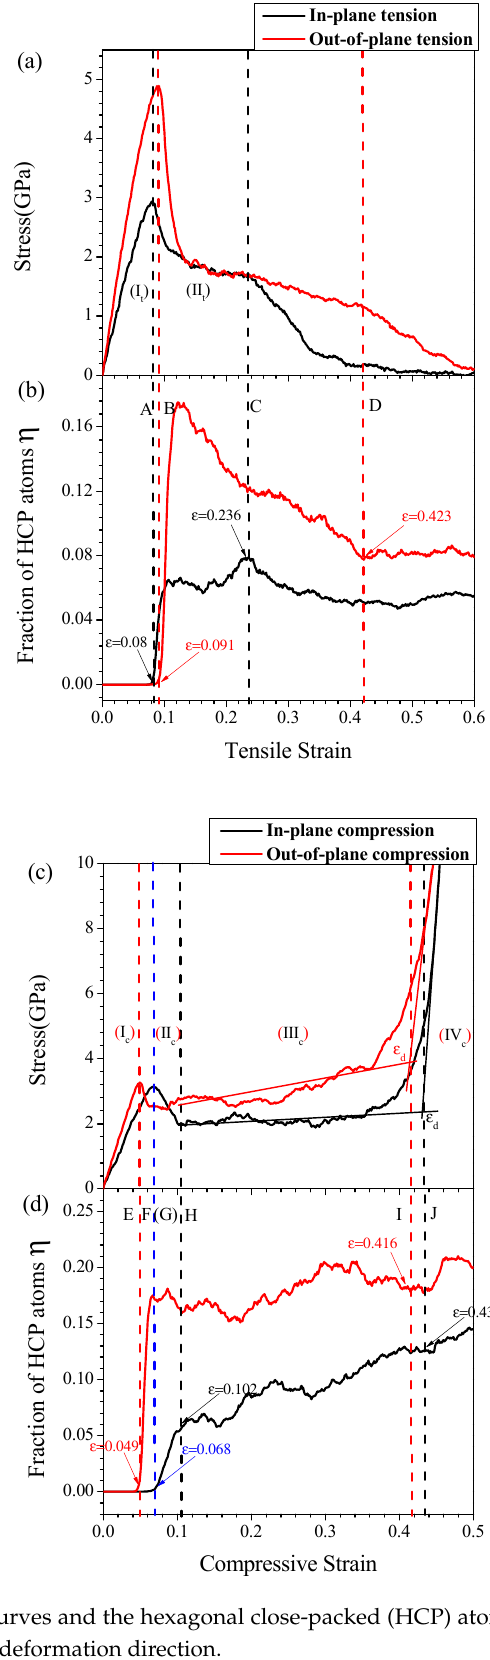
Figure 2. Stress-strain curves and the hexagonal close-packed (HCP) atom fraction η of group 4 for HONNs along different deformation direction.